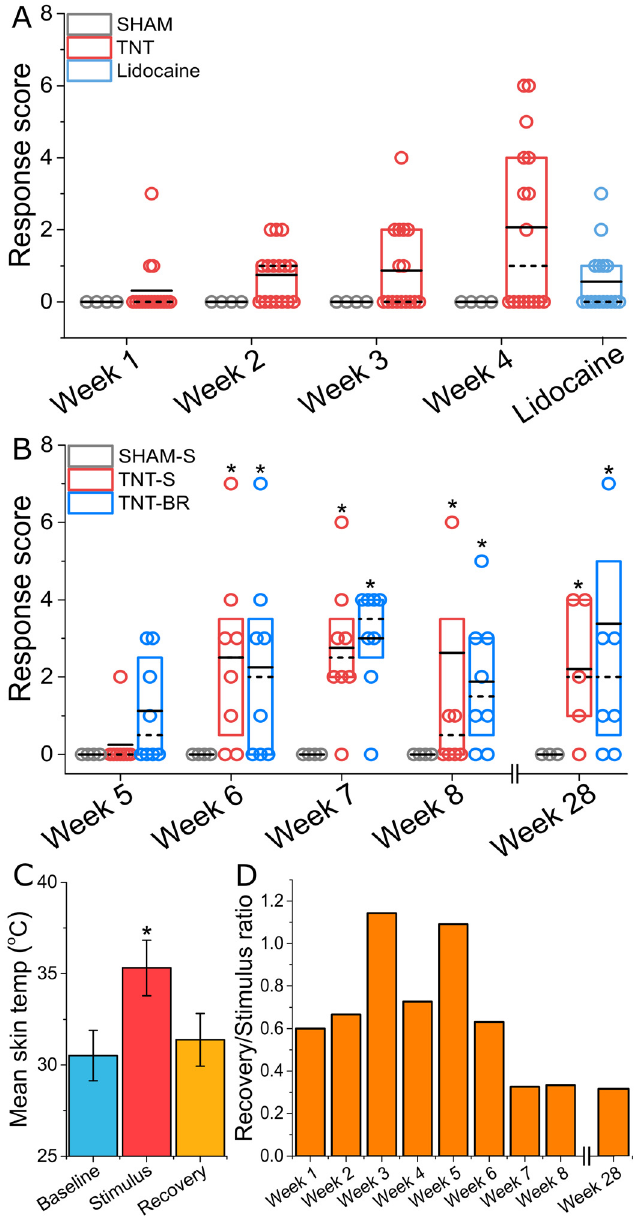
Fig 3. Thermal stimulus elicits post-neurotomy pain. (A) Hollow circles indicate the summed behavioral response score for each animal for both TNT (red) and SHAM (grey) groups. Statistically significant mean pain response scores (solid black line) were observed between TNT and SHAM groups in week 4 and in weeks 6 – 8, following bulb resection (B). Lidocaine was found to be a successful moderator of heat-induced neuroma pain. Dashed black lines indicate population median. (B) Following bulb resection surgery, significant heat-induced neuroma pain persisted from week 6 until week 28. No statistically significant difference was found between animals receiving bulb resections vs TNT-SHAM animals. For statistical comparisons between groups, a two-tailed Mann-Whitney test was used ( * p < 0.05, ** p < 0.01). (C) Thermal stimulus exposure induces a significant mean skin temperature increase. A mean skin temperature increase of approximately 5°C was observed following 5 minutes of heat-lamp exposure. (D) Recovery-to-Stimulus behavioral response ratios for all time